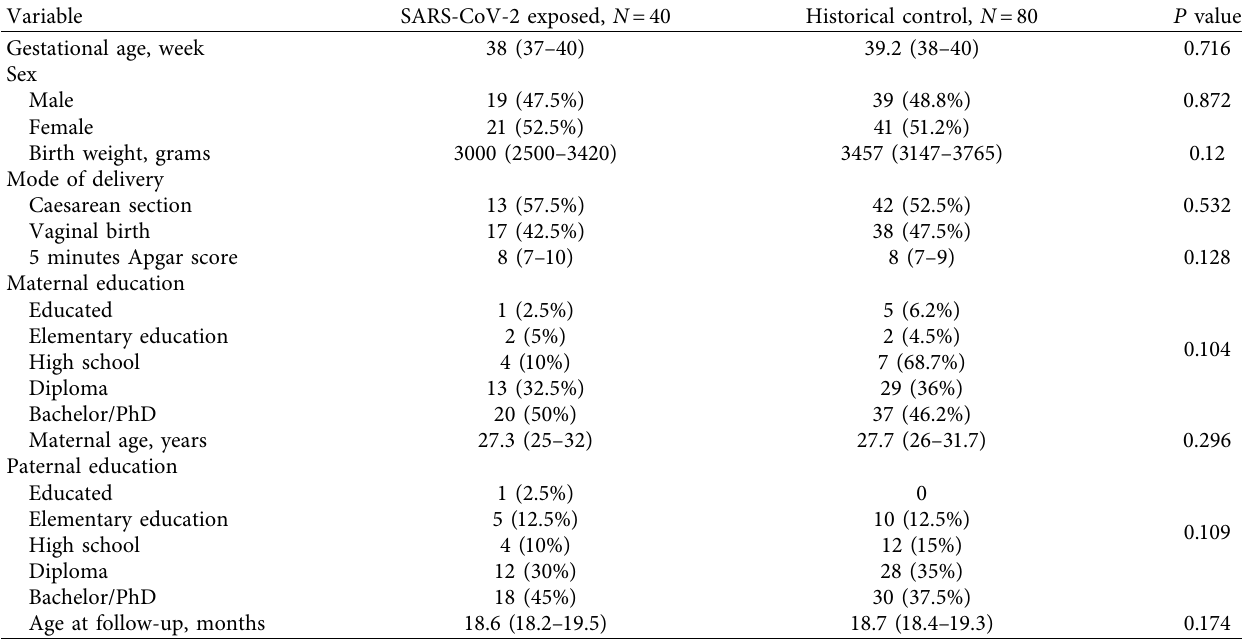
Table 1: Demographic characteristics of the study